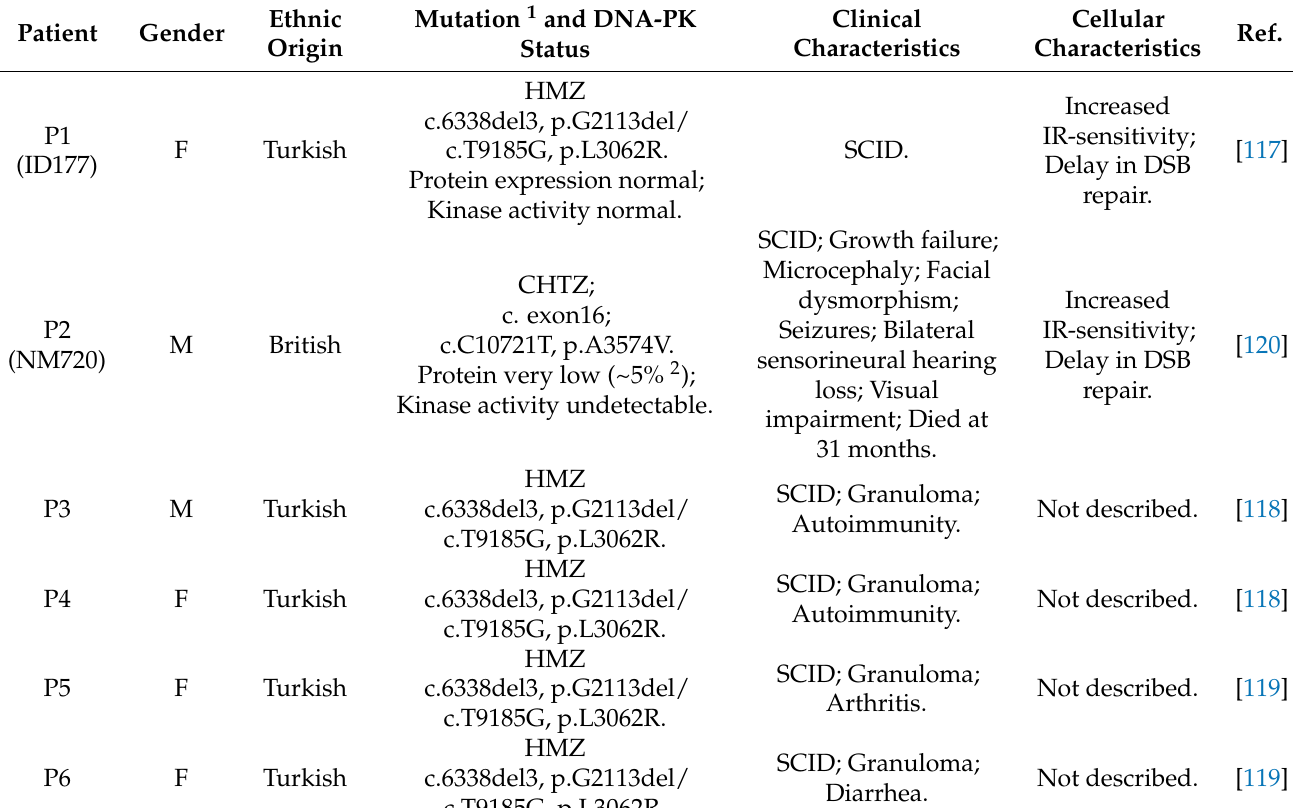
Table 5. Human patients deficient in